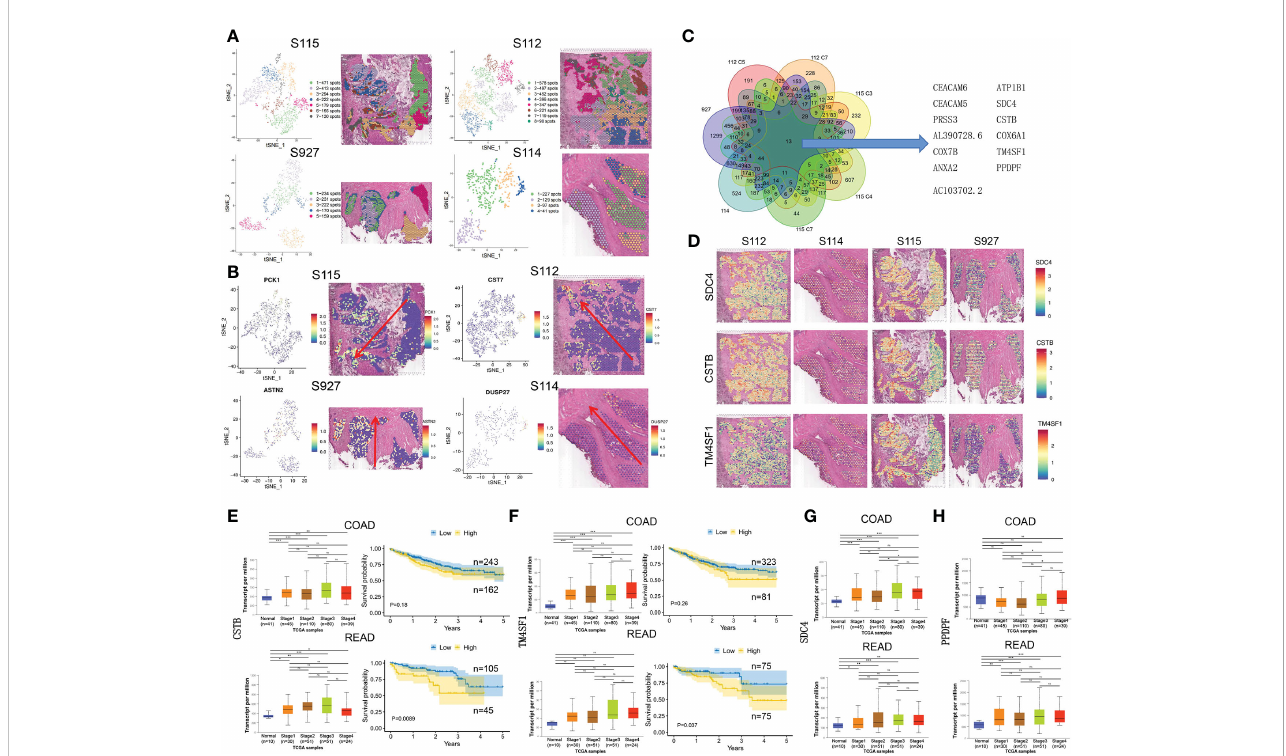
FIGURE 3 The up-regulated genes in invasive clusters that were associated with prognosis of CRC patients. (A) Left: four tSNE map shows the results of the dimensionality reduction and clustering analysis of the S115, S112, S114, and S927 separately. Right: the fi gure re fl ects the distribution of these clusters in the corresponding sample. (B) Left: the spatial distribution of the four invasive clusters ’ marker gene. Right: the visualization of expression in the corresponding samples. (C) Thirteen genes were screened out from the four CRC samples, which were commonly highly expressed in the invasive clusters. (D) Expression of SDC4 (upper panel), CSTB (middle panel), and TM4SF1 (lower panel) in four CRC samples. (E, F) The relationship of CSTB (E) and TM4SF1 (F) expression level and cancer stage/ progression-free survival in colon cancer (up) and rectal cancer (down) from TCGA database. (G, H) The relationship of CSTB (G) and PPDPF (H) expression level and cancer stage in colon cancer (up) and rectal cancer (down) from TCGA database. *P < 0.05, **P < 0.01 and ***P < 0.001. NS, not signi fi cant